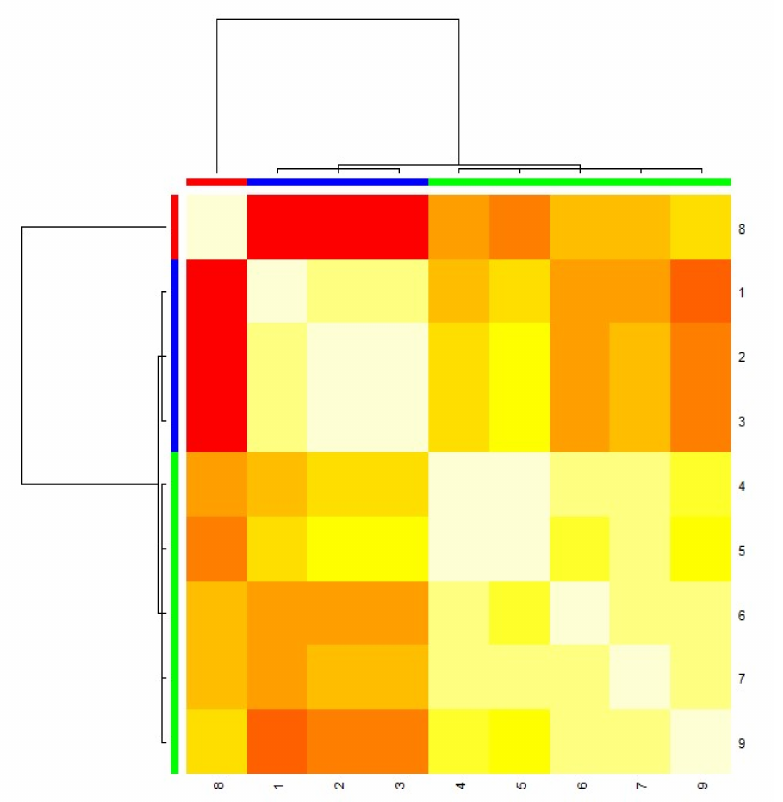
Figure 9. Cluster heatmap of the nine OA runs simultaneously taking into account the response of the three water quality indices (confirmation